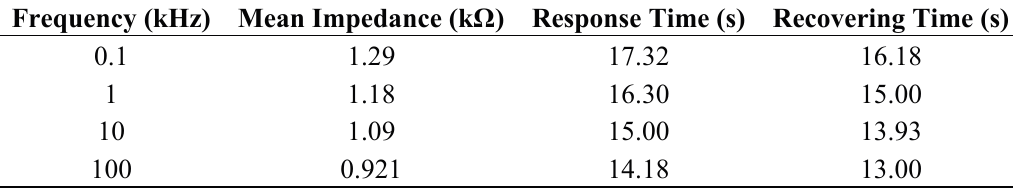
Table 3. Variations of the impedance measurement at 300